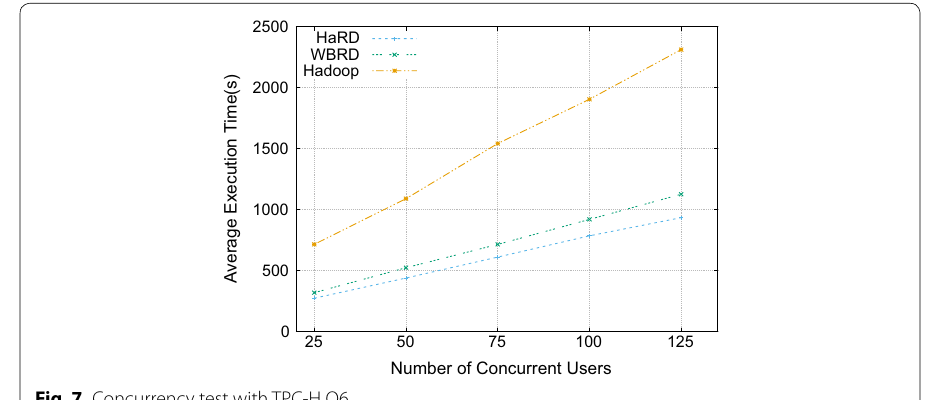
Fig. 7 Concurrency test with TPC-H